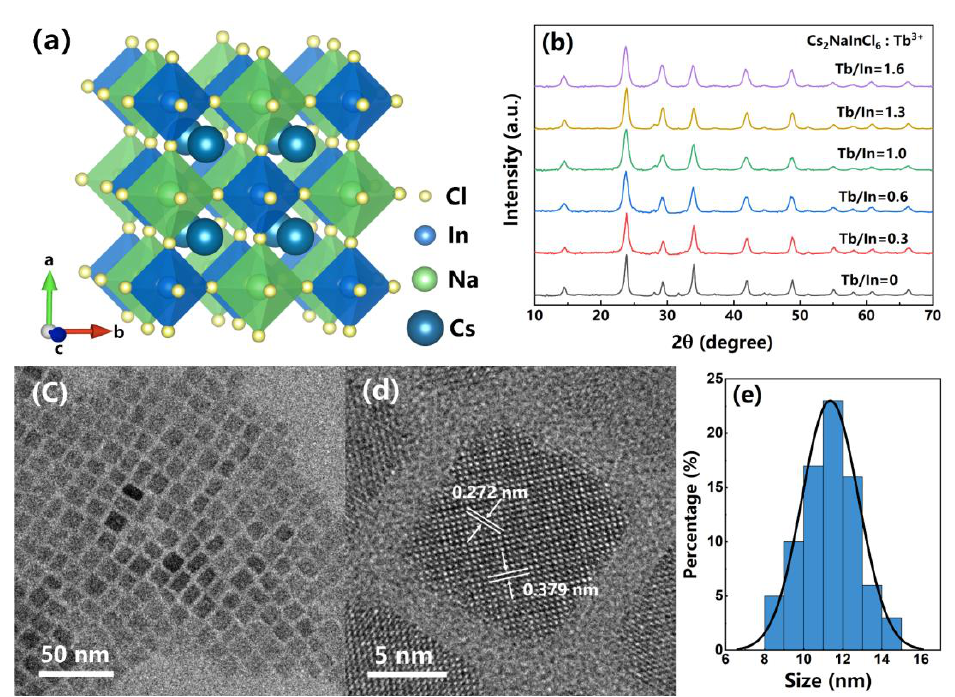
Figure 1. ( a ) Cs 2 NaInCl 6 NCs lattice structure, with yellow, blue, and green spheres representing Cl, In, and Na atoms, and bigger blue spheres representing Cs atoms. ( b ) PXRD patterns of the undoped and Tb 3+ -doped Cs 2 NaInCl 6 DP NCs. ( c ) TEM and ( d ) HRTEM images of Tb 3+ -doped Cs 2 NaInCl 6 DP NCs. ( e ) Histogram of the size distribution of Tb 3+ -doped Cs 2 NaInCl 6 NCs. The optical properties of the Tb 3+ -doped Cs 2 NaInCl 6 DP NCs were investigated using steady-state PL and absorption spectra. The PL spectra under 280 nm excitation for Table 2. The EDS results of Tb 3+ -doped Cs 2 NaInCl 6 DP NCs. Cs 2 NaInCl 6 NCs with different Tb 3+ doping ratios are shown in Figure 2a. The Tb 3+ -doped Element Cs 2 NaInCl 6 NCs exhibit a major narrow green PL peak at 544 nm derived from the transi- tion of Tb 3+ 5 D 4 7 F 5 , with three other small emission peaks at 490 nm, 583 nm, and 622 nm derived from the transitions of Tb 3+ 5 D 4 7 F 6 , 5 D 4 7 F 4 , and 5 D 4 7 F 3 [21,37]. The PL intensity